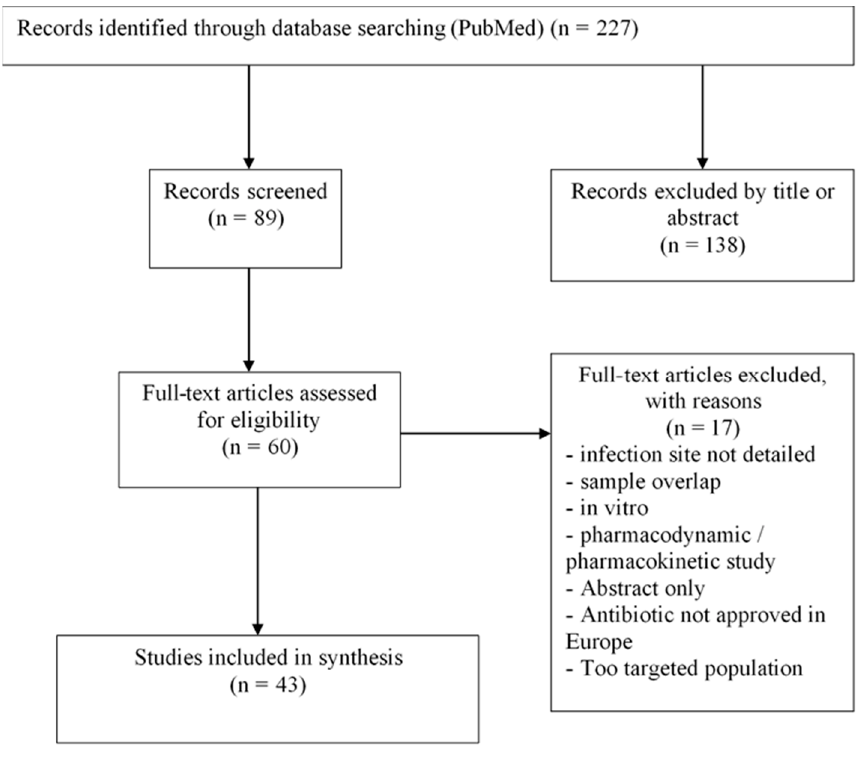
Figure 1. Flow-chart. Figure 1.